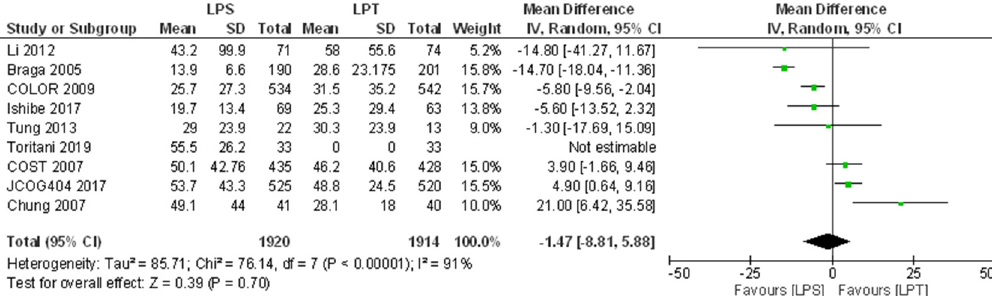
Figure 2. Forest plot of comparison: Mean difference for the overall survival. LPS: laparoscopic approach; LPT: open approach (laparotomy).